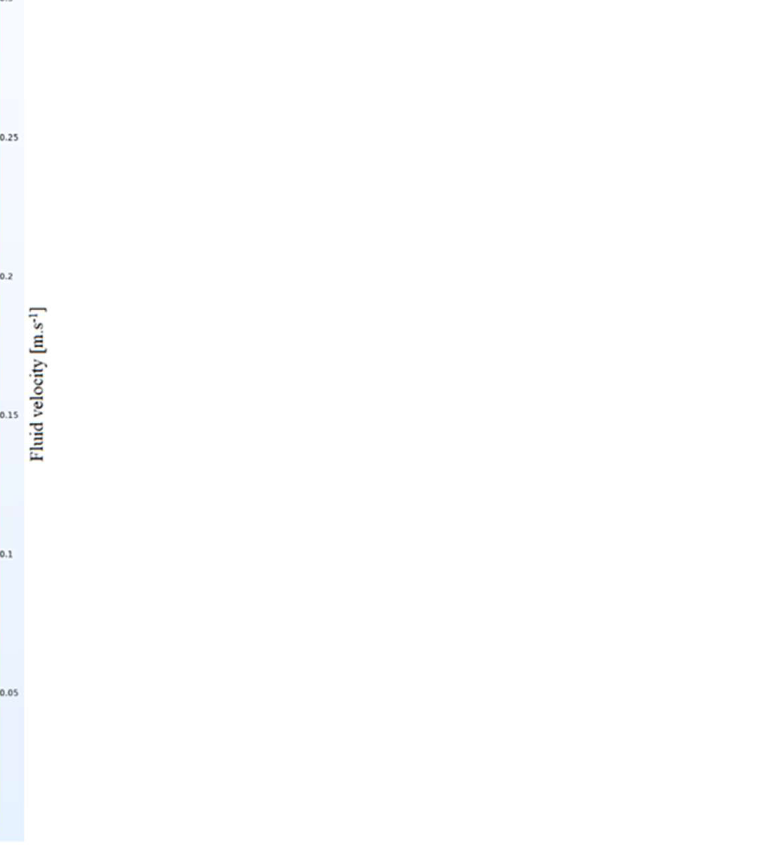
Figure 7. 3D view of stack of three 80 PPI modelled CFF at 0.16 m.s −1 outflow velocity.